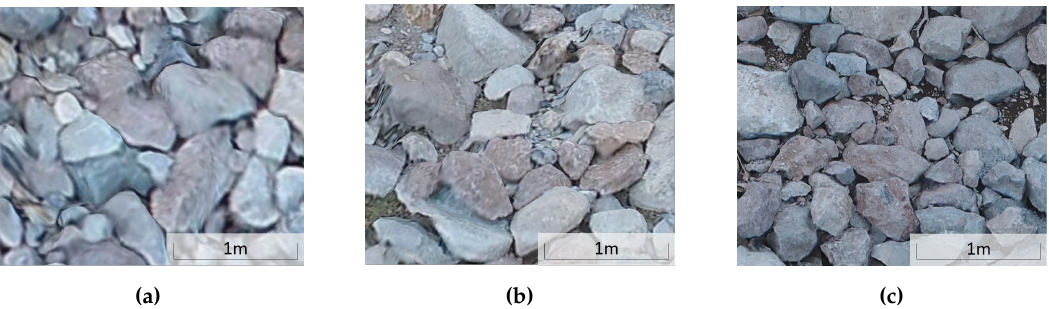
Figure 11. Visual comparison of riprap extracts from ( a ) low, ( b ) medium and ( c ) high-priority regions of final SfM